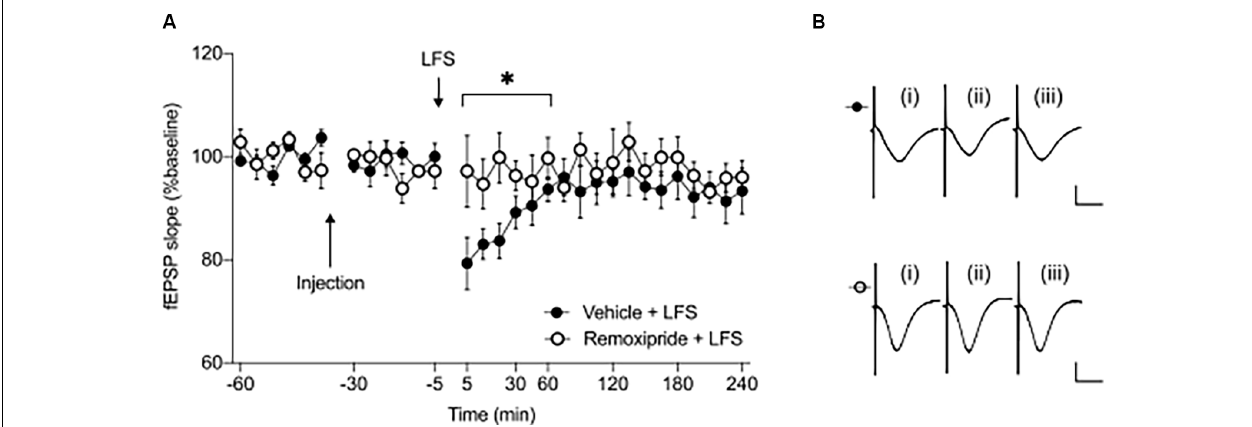
FIGURE 2 | Short-term depression at the CA3-CA1 synapse is prevented by pharmacological antagonism of D2-like receptors (D2R). (A) Remoxipride (50 µ g) blocked the initiation of short-term depression induced by low frequency stimulation ( n = 6, ∗ p < 0.05). Arrows indicate the time-points of injection or low frequency stimulation. Filled circles represent the control experiments results, while open circles indicate experiments where drug was applied prior to LFS. Values are expressed as ± SEM. (B) Examples of analog responses recorded during low-frequency stimulation experiments with either vehicle treatment (filled circles) or remoxipride injection (open circles). In each case (i) shows an fEPSP evoked in the first 30 min of recordings; (ii) shows an fEPSP evoked at the 5 min time-point; and (iii) represents an fEPSP recorded at the 240 min timepoint. Scale bars represent: 1 mV vertical/10 ms horizontal.